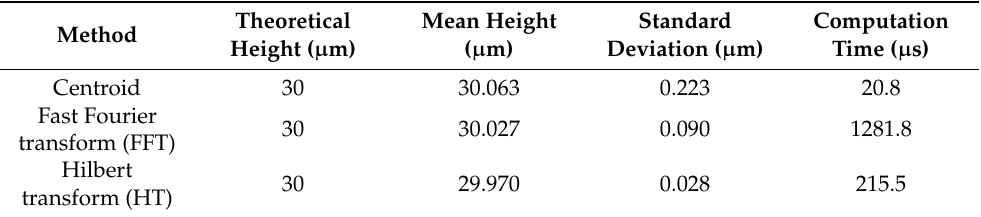
Table 1. Comparison of simulation results obtained by the three